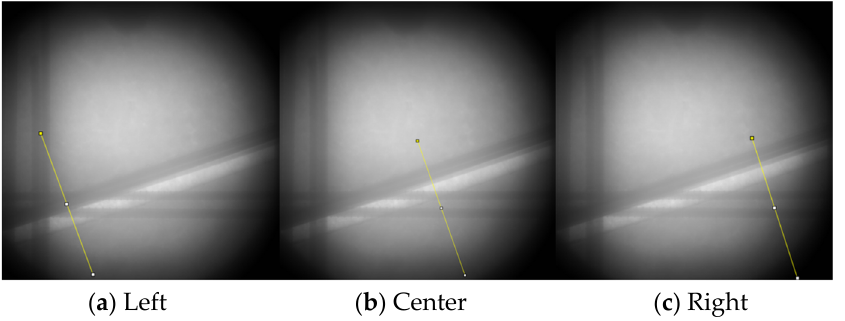
Figure 22. Compensated profile of Figure 20 by subtracting the ununiform background due to the X-ray point source.